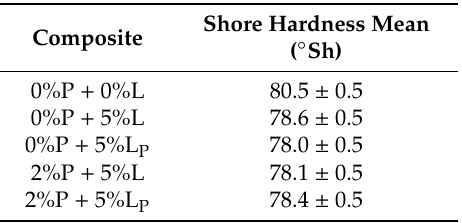
Table 5. Shore hardness of the composites.